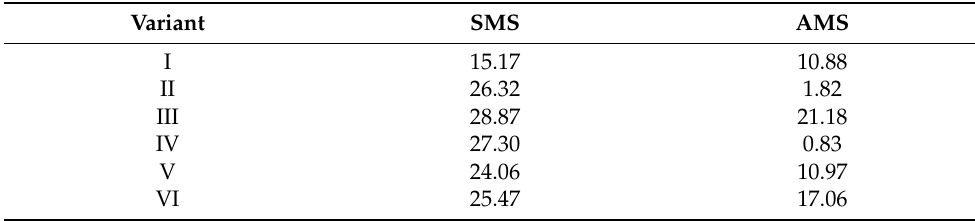
Table 2. RMSDs of estimated displacements from the combined observation set